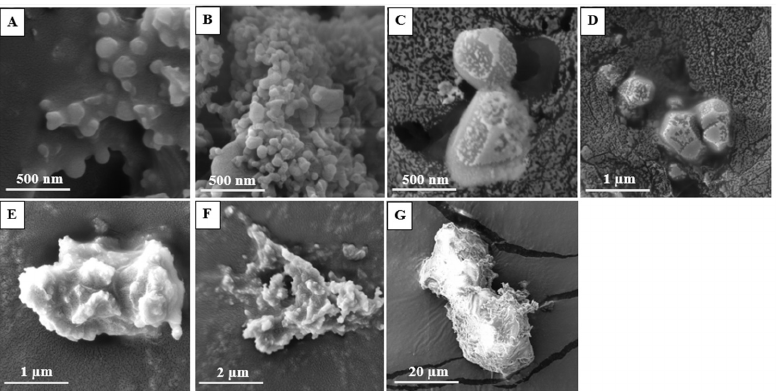
Figure 11. SEM photomicrographs of PEtOx powder before and after incubating in SLF at different time intervals ( A ) PEtOx original powder ( B ) PEtOx 1 week ( C ) PEtOx 2 weeks ( D ) PEtOx 3 weeks ( E ) PEtOx 4 weeks ( F ) PEtOx 5 weeks ( G ) PEtOx 6 weeks.